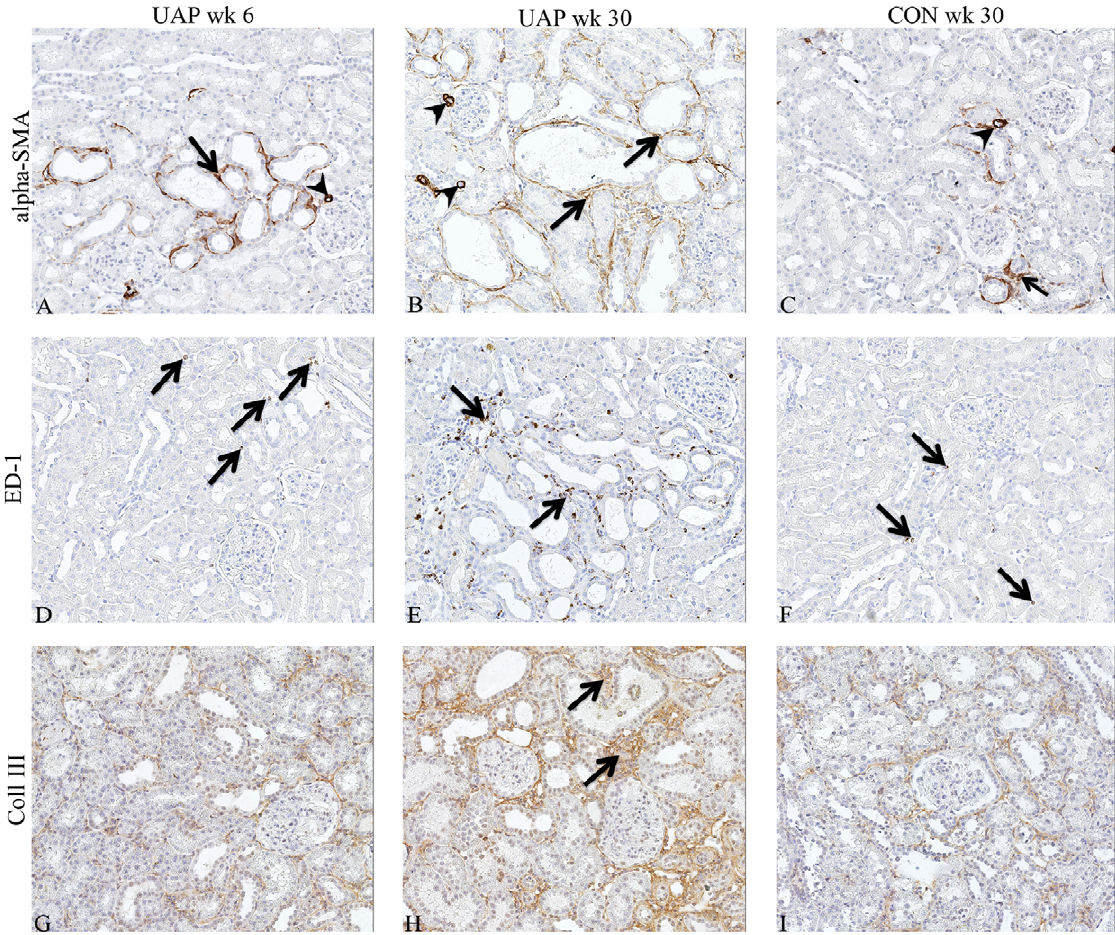
Figure 2. Representative photographs of renal damage markers in adriamycin-exposed and control kidneys. Interstitial a -SMA increased progressively in proteinuric kidneys during follow up (A, B). a -SMA was located around dilated tubules (arrows) and in blood vessels (arrowheads). In control kidneys at week 30, only very limited expression of interstitial a -SMA was present (C). Interstitial macrophage influx increased in ADR animals (D, E). ED-1 positive cells were found mostly around damaged tubules (arrows) and sporadically present in the interstitium of control kidneys (F). Immunostaining of collagen III was found in ADR animals (G, H; arrows), and rarely in controls (I).